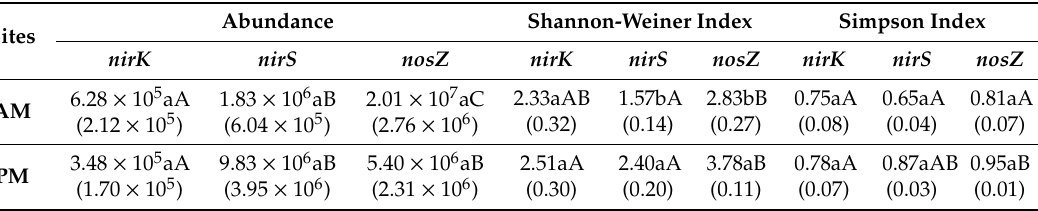
The average abundance and α -diversity of nirK , nirS , and nosZ gene harboring denitrifying bacterial communities in the Acacia mangium (AM) and Pinus massoniana (PM) plantations. The α -diversity is represented by Shannon-Weiner and Simpson indices. The average value was calculated from five replicates in each type of plantation, and the standard error is shown in brackets. Di ff erent lowercases mean the significant di ff erence between AM and PM plantations, and di ff erent capitals indicate the significant di ff erence among the three genes within one type of